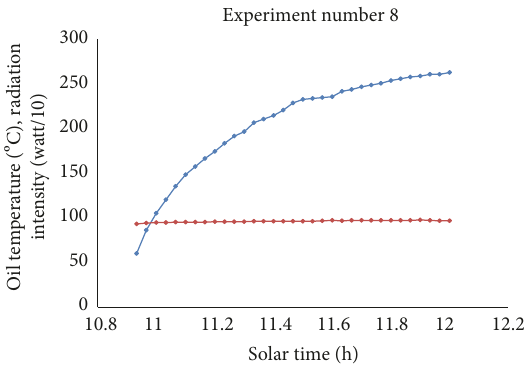
Figure 15: Plot of temperature (blue) and solar radiation intensity (red) versus time for the second experiment with 850 gm of vegetable oil load. Radiation intensity is divided by 10 to fi t the scale.